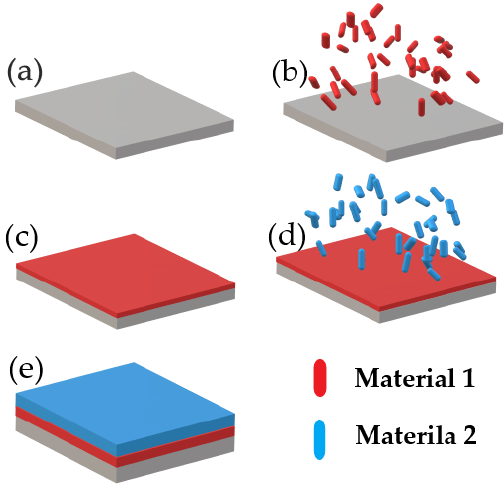
Figure 19. ALD Process diagram: ( a ) prepared substrate; ( b ) evaporated particles of Material 1; ( c ) deposited Material 1; ( d ) evaporated particles of Material 2; ( e ) deposited Material 1.